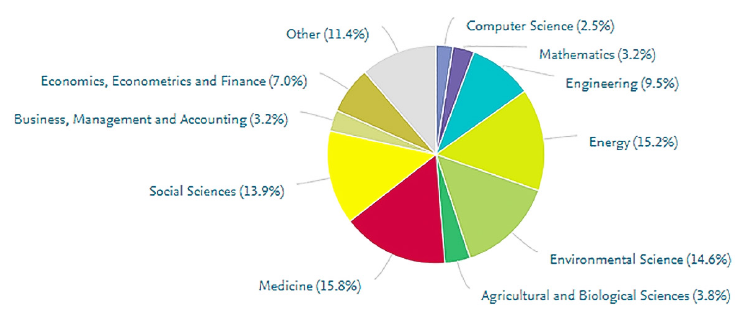
Figure A2. Structural analysis by subjects for the case of SDG 7 and Investment